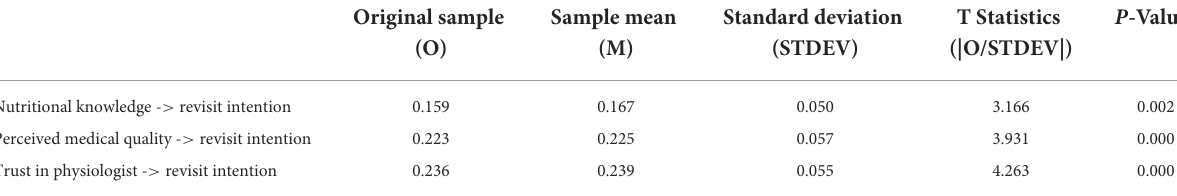
TABLE 3 The direct effects of HRM practices on operational